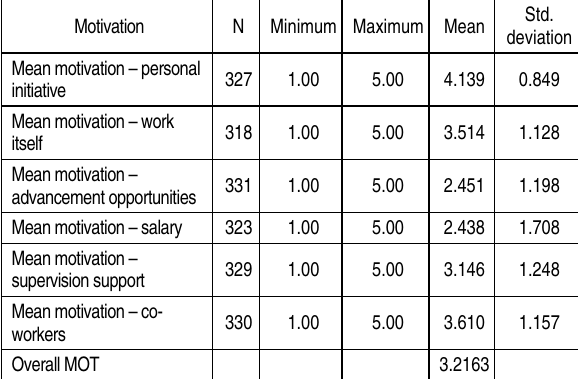
Table 2. Level of municipal employee